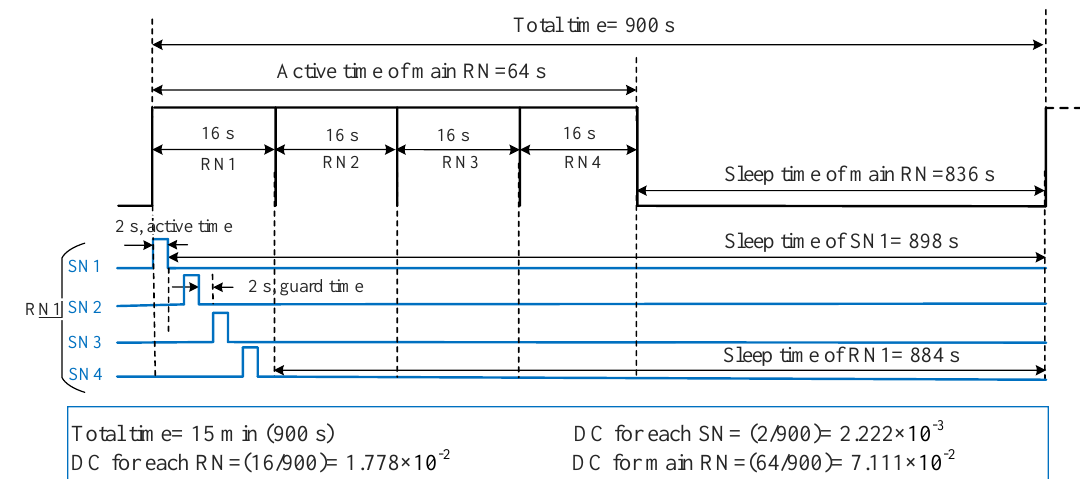
Figure 6. Timing diagram of the sleep/wake scheme of the sensor and router nodes.